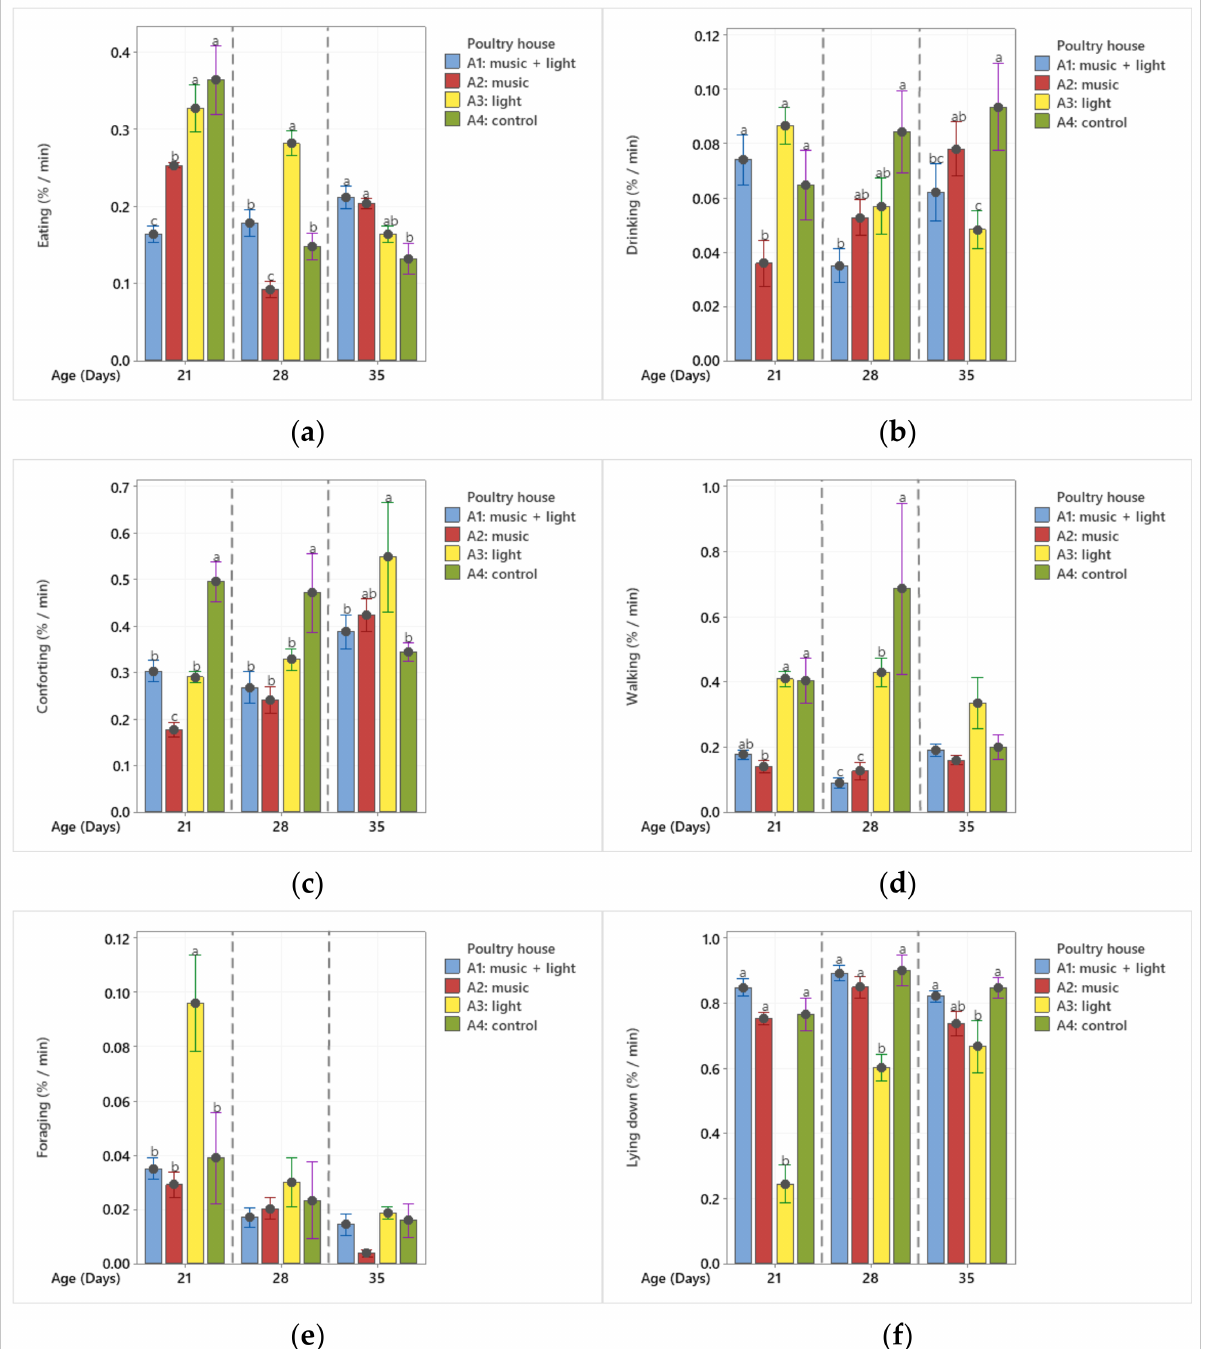
Figure 3. Graphs of means and respective standard errors observed over six minutes for behaviors (( a ) eating, ( b ) drinking water, ( c ) comforting, ( d ) walking, ( e ) foraging, and ( f ) lying) and the result of the Fisher test ( p < 0.05) of significance for each evaluated age. Comforting behaviors (dust bathing, standing up, preening, and stretching) were observed more frequently in the control treatment (A4) in 21- and 28-day-old broilers. The light treatment did not stimulate the comforting behaviors until 35 days of age; even in this case, there was no difference between groups A2 (music) and A3